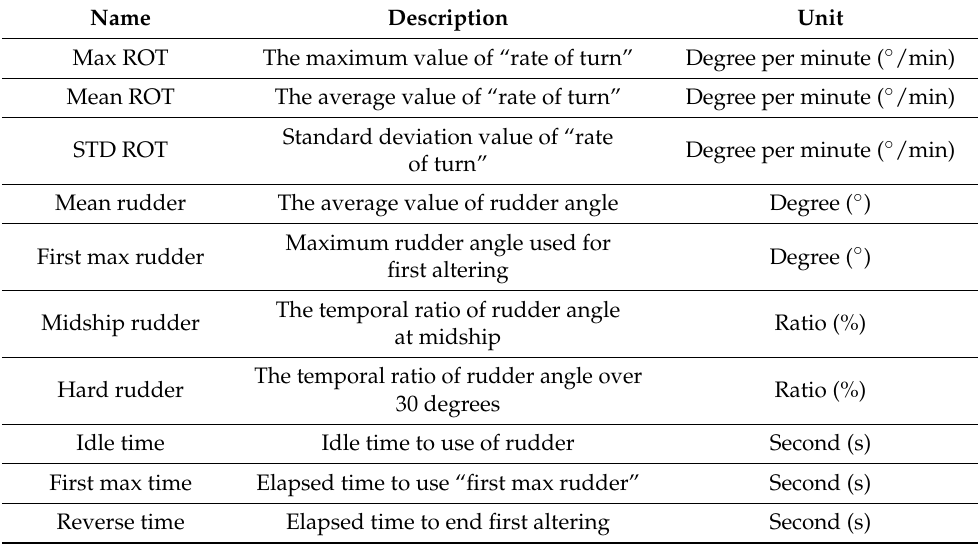
Table 3. List of steering